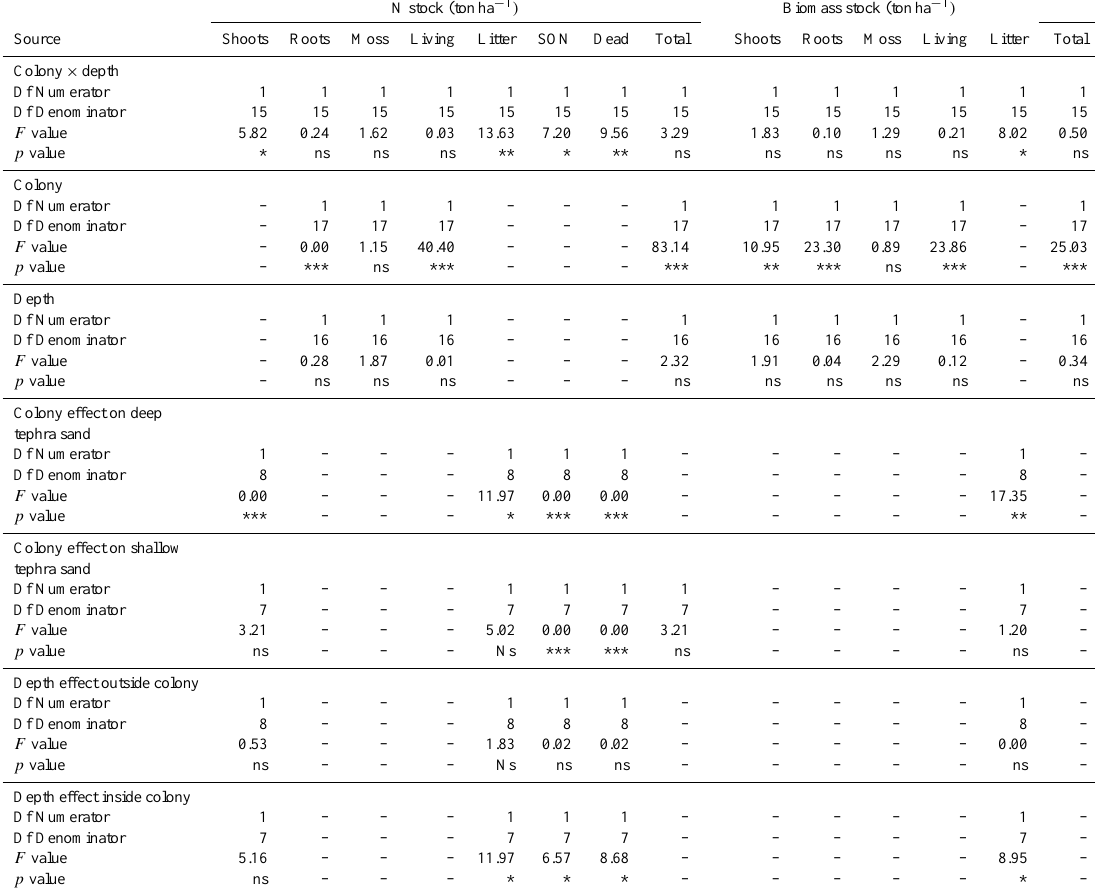
Table 1. Results of the two-way ANOVA for N stock, biomass stock, C stock and N accumulation rate, using seabird colony and tephra depth as fixed variables. “Shoots” include all aboveground living plant parts, “Living” includes “Shoots” and “Roots” and “Dead” includes “Litter” and SON or SOC. Significant source variables ( p <0.05) with respect to ecosystem parts are indicated with an asterisk: ns is p >0.05, * p